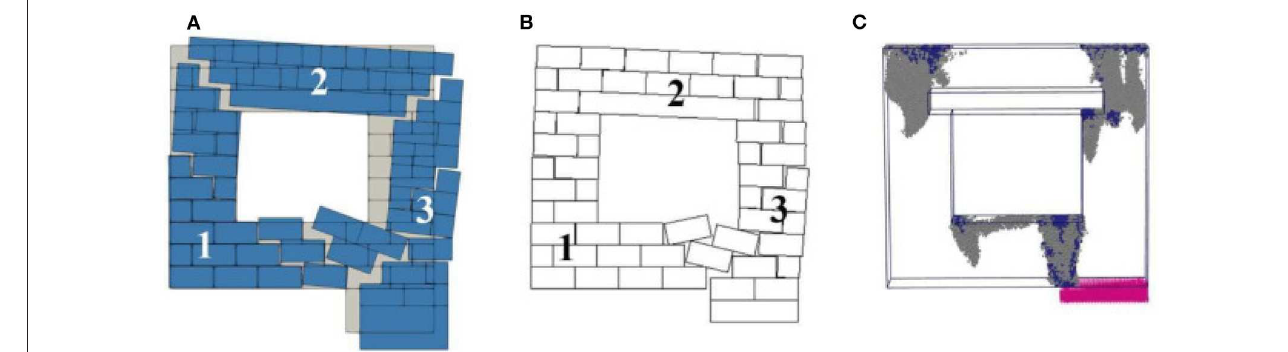
FIGURE 8 | (A) LA, (B) FEM/DEM, and (C) FEM results for Panel 1 case.